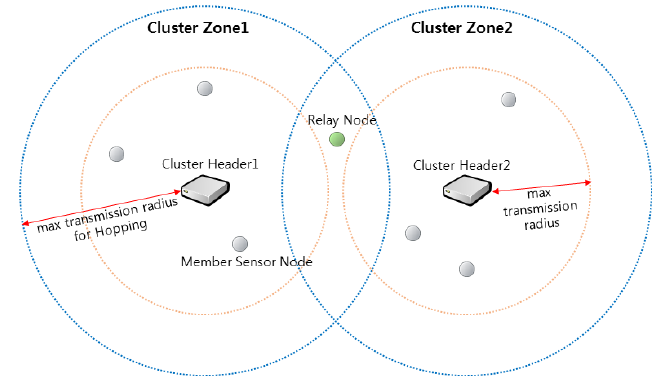
Figure 2. The definition of the terms in hopping sensor networks.